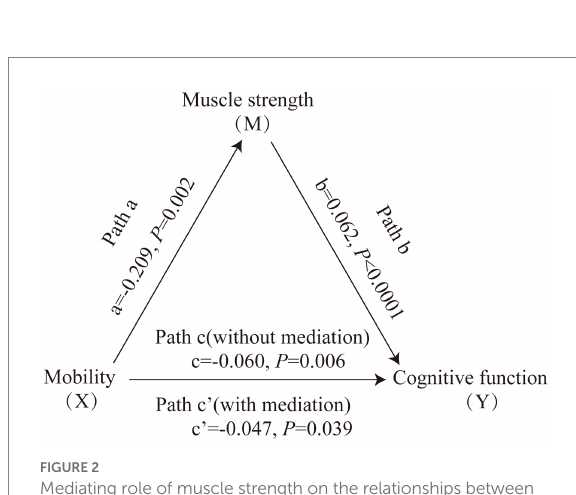
FIGURE 2 Mediating role of muscle strength on the relationships between mobility and cognitive function in community-dwelling older adults with normal cognition. The capital letters X, M, and Y were used to represent mobility, lower extremity muscle strength and cognitive function, respectively. The mediating effect tested the four following pathways (regression coefficients): mobility on muscle strength (Path a), muscle strength on cognitive function (Path b), mobility on cognitive function without medication (Path c), mobility on cognitive function with medication (Path